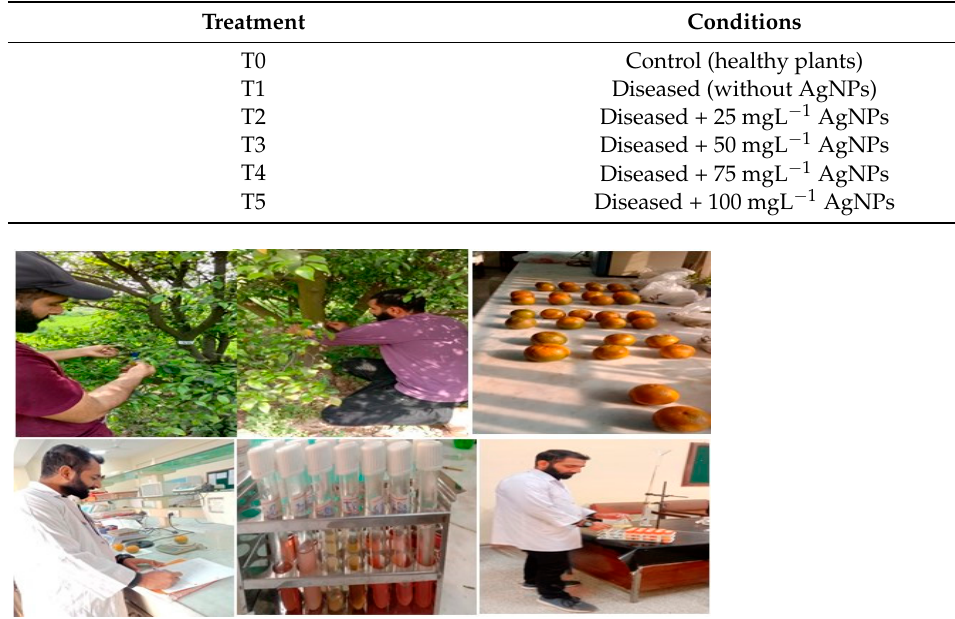
Table 1. AgNPs treatment plan.